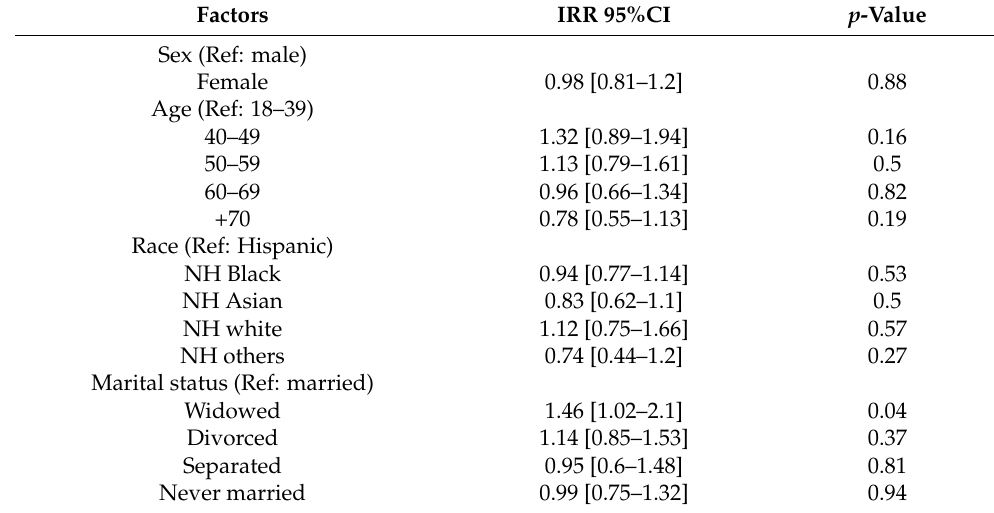
Table 6. Determinants of healthcare events associated with diabetes: negative binomial regression